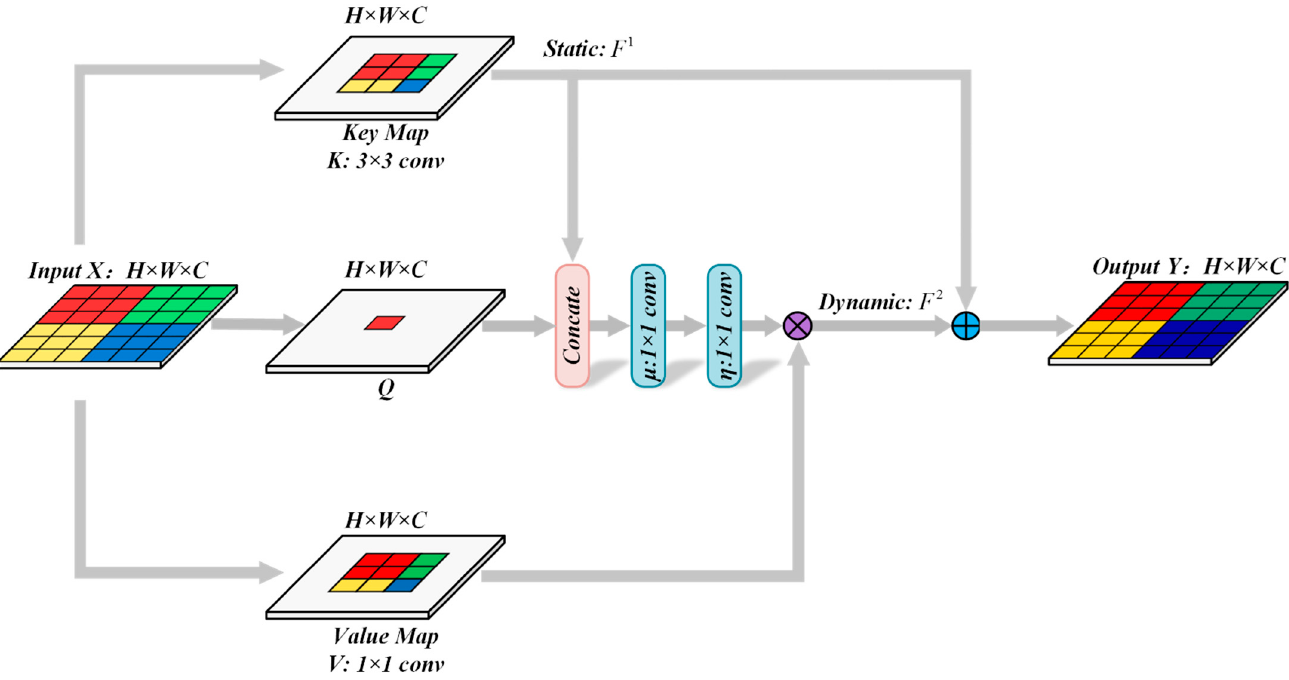
Figure 3. The detailed calculation process of the CoT module.